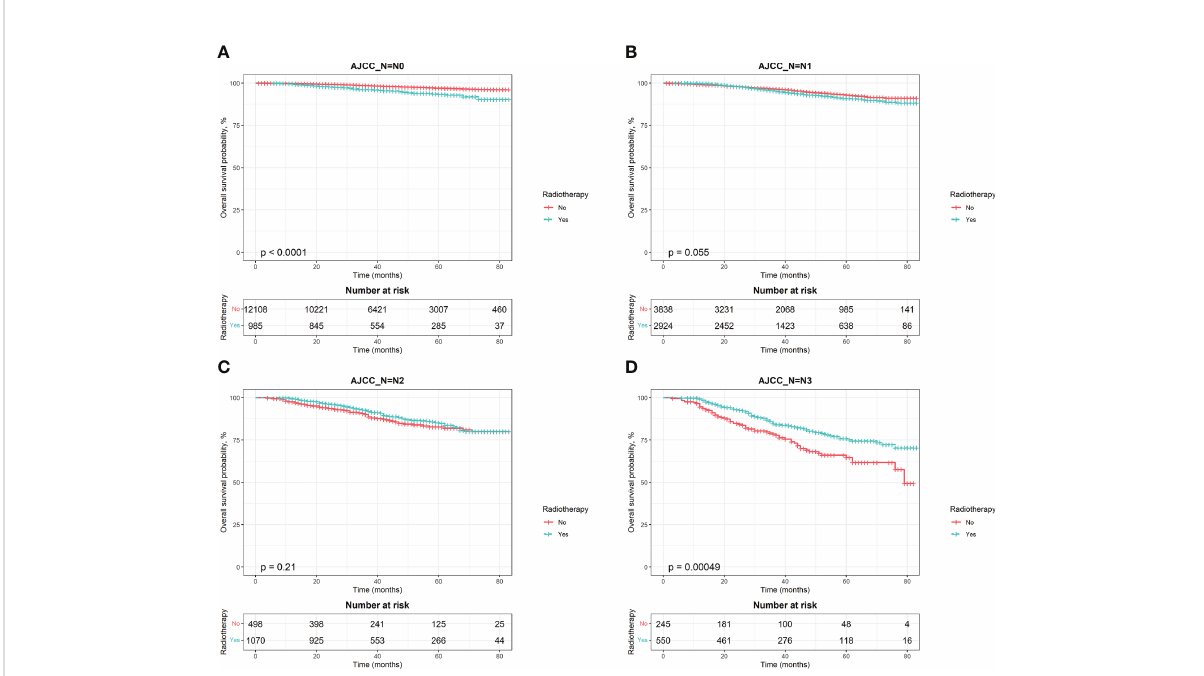
FIGURE 4 Kaplan – Meier survival curves of overall survival after stratifying by AJCC N stage. (A) , AJCC_N=N0; (B) , AJCC_N=N1; (C) , AJCC_N=N2; (D) , AJCC_N=N3.